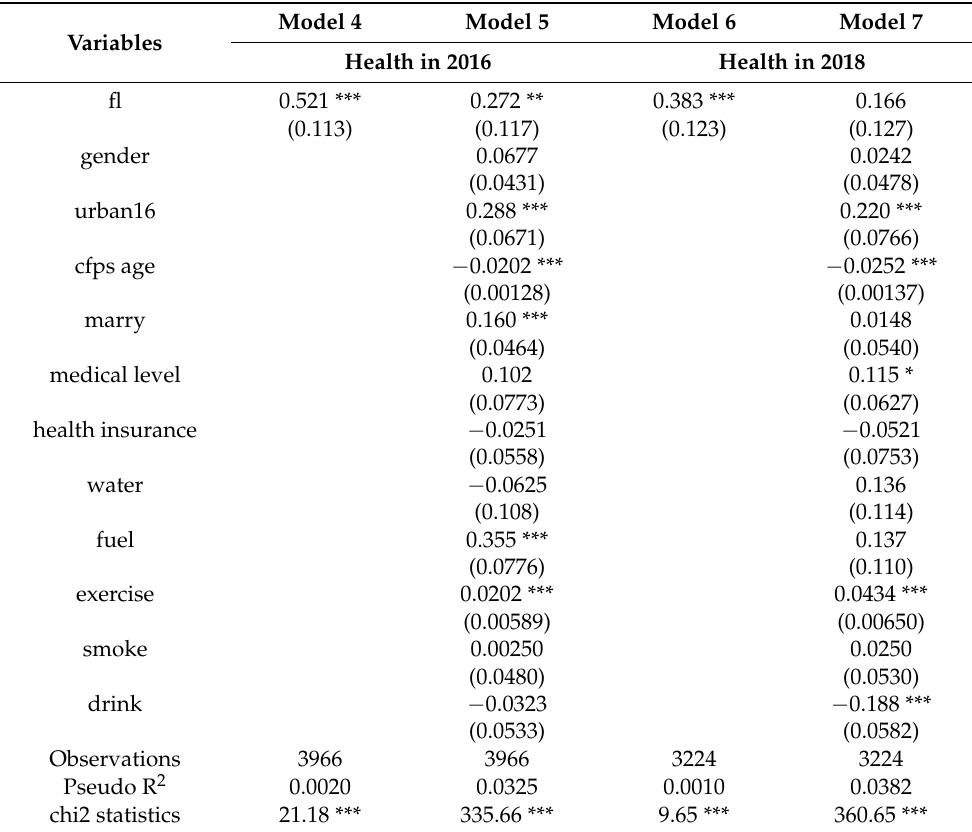
Table 5. Results of the long-term effect